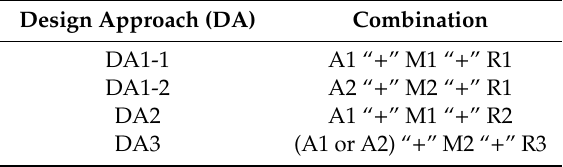
Table 1. Design approaches and combinations.